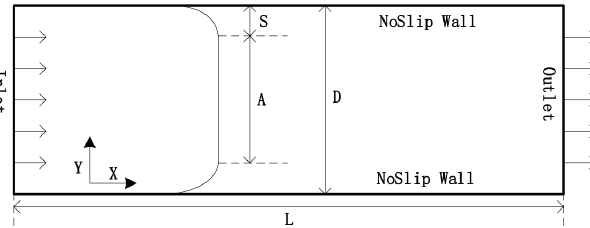
Figure 1. Schematic of the flow between parallel plates. Table 2. Rheological parameters of a simulated Bingham